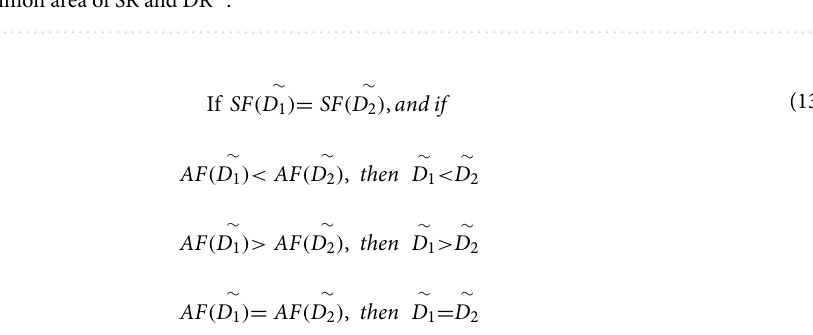
Figure 2. The common area of SR and DR 26